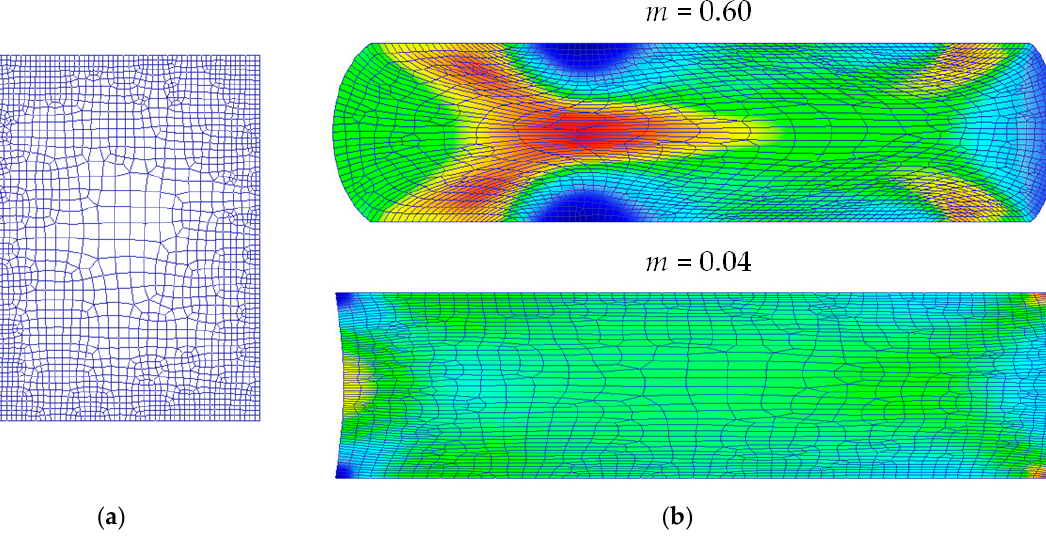
Figure 5. Finite Element Method (FEM) simulation of RCT for different friction conditions. ( a ) Initial mesh (axisymmetrical model); ( b ) Deformed samples for different friction conditions (top: m = 0.6; bottom: m = 0.04).